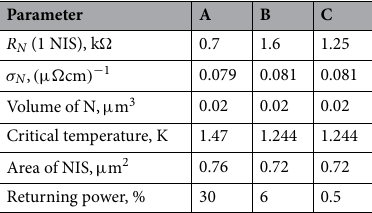
Table 1. Parameters of the samples.